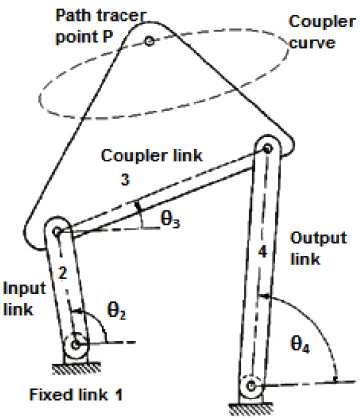
Figure 1. A four-bar linkage.